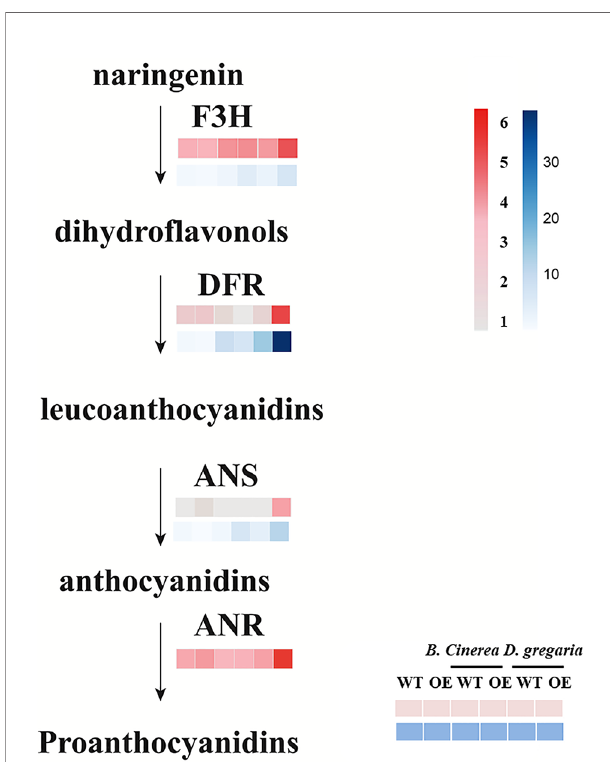
FIGURE 5 | Expression patterns of fl avonoid pathway genes in transgenic and control plants infected by two pathogens. Among them, pink blocks are gene expression patterns based on transcriptome data analysis, while blue blocks are qRT-PCR validation results for these genes. Error bars indicate ±